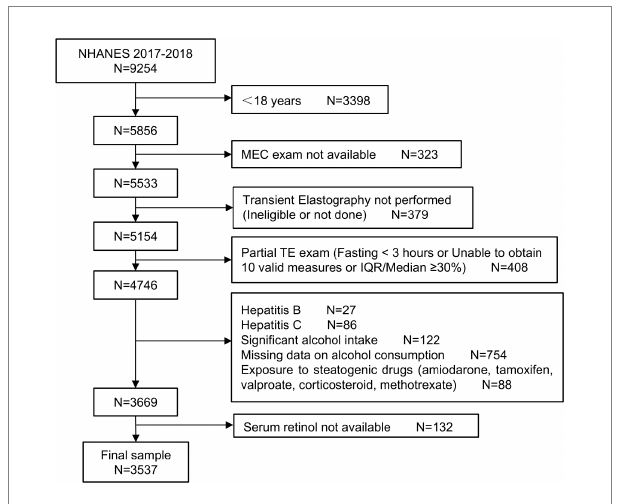
FIGURE 1 Flowchart of the study